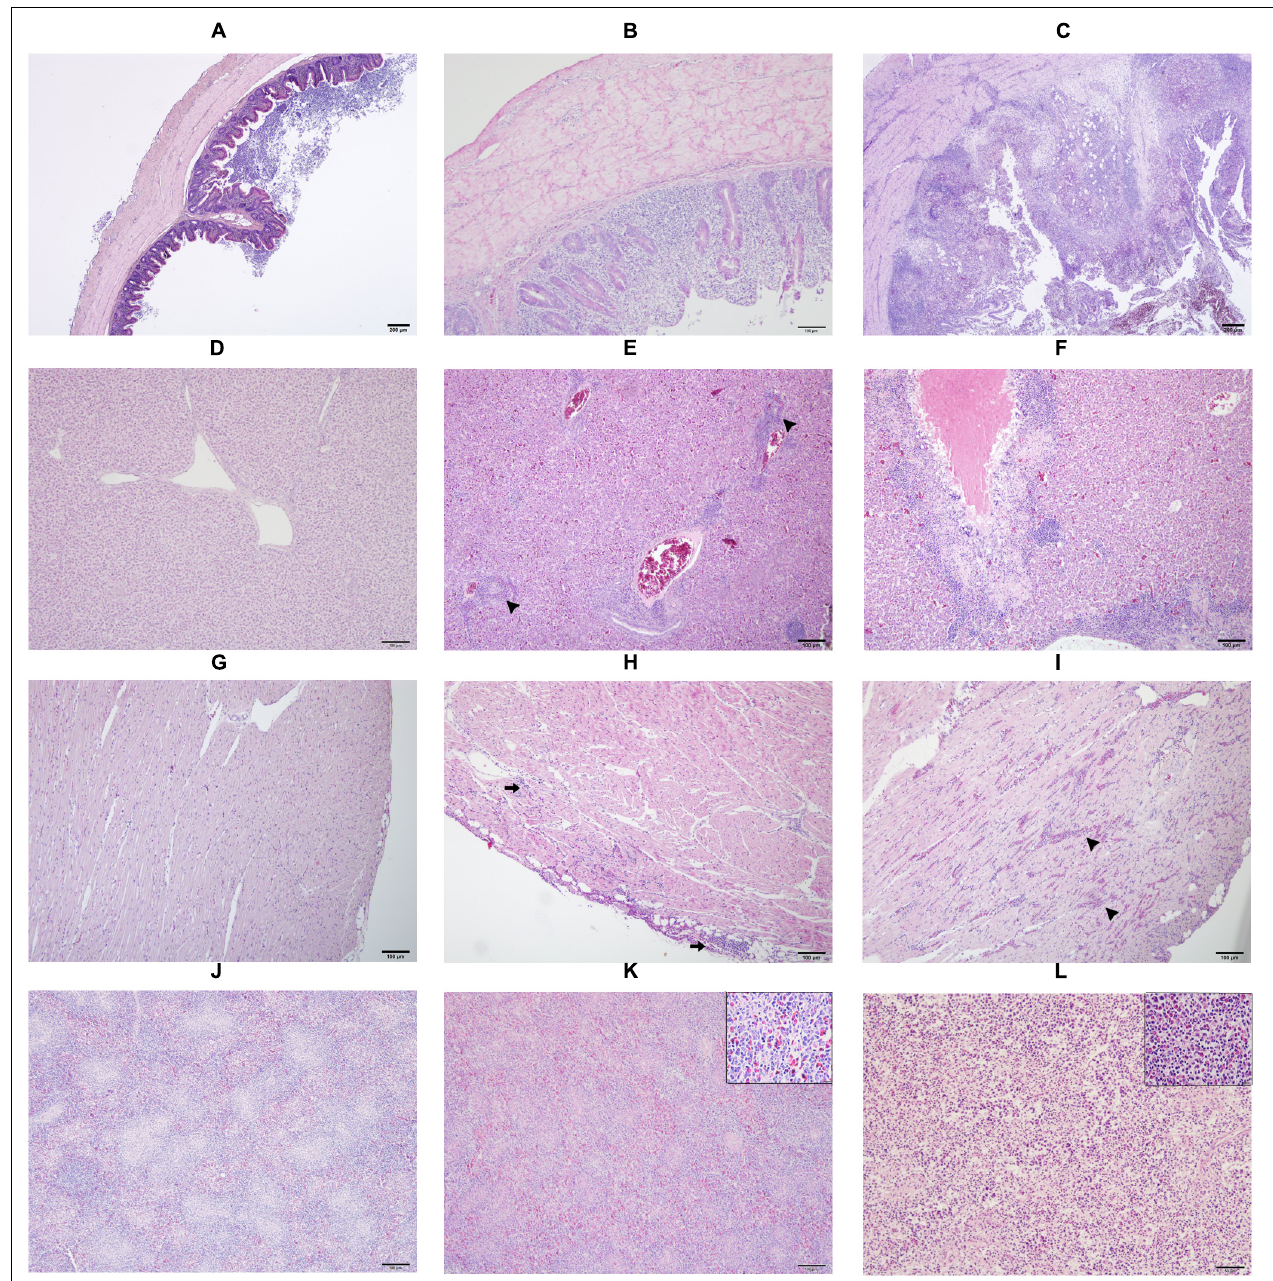
FIGURE 1 | Microscopic lesion scores (LS) in caecum (A–C) , liver (D–F) , heart (G–I) and spleen (J–L) of commercial chicken layers infected with a lux -tagged E. coli with or without H. meleagridis. Caeca: normal without pathological changes, LS0 (A) ; epithelial erosion with infiltration of inflammatory cells in the mucosa, LS1 (B) ; severe fibrino-necrotic typhlitis with transmural inflammatory cell infiltrate, LS2 (C) . Liver: normal without pathological changes, LS0 (D) ; congestion with periportal infiltration of inflammatory cells (arrow heads), LS1 (E) ; coalescing necrotizing hepatitis surrounded mostly by lymphocytic cells, LS2 (F) . Heart: normal without pathological changes, LS0 (G) ; cellular infiltrate in the epicardium that extended to the myocardium (arrows), LS1 (H) ; multifocal interstitial inflammatory infiltrates, mostly granulocytes as indicated by arrow heads, LS2 (I) . Spleen: normal without pathological changes LS 0 (J) ; mild heterophilic infiltration (inset), LS1 (K) ; severe heterophilic infiltration with lymphoid depletion (inset), LS 2 (L) .